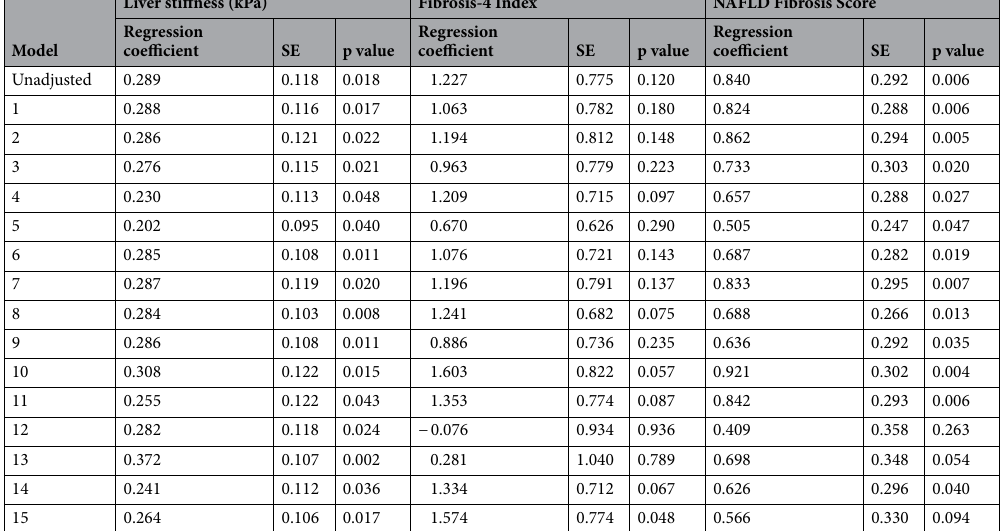
Table 3. Multiple regression analysis with coronary artery score as the outcome variable. SE standard error. Model 1: adjusted for sex. Model 2: adjusted for carbohydrate intolerance. Model 3: adjusted for diabetes. Model 4: adjusted for hypertension. Model 5: adjusted for dyslipidaemia. Model 6: adjusted for obstructive sleep apnea syndrome. Model 7: adjusted for hyperuricemia. Model 8: adjusted for statin therapy. Model 9: adjusted for aspirin therapy. Model 10: adjusted for obesity. Model 11: adjusted for smoking. Model 12: adjusted for visceral adipose tissue. Model 13: adjusted for visceral adipose tissue/subcutaneous adipose tissue ratio. Model 14: adjusted for presence of carbohydrate intolerance, hypertension, dyslipidaemia, and obesity (number of factors). Model 15: adjusted for presence of carbohydrate intolerance/diabetes,